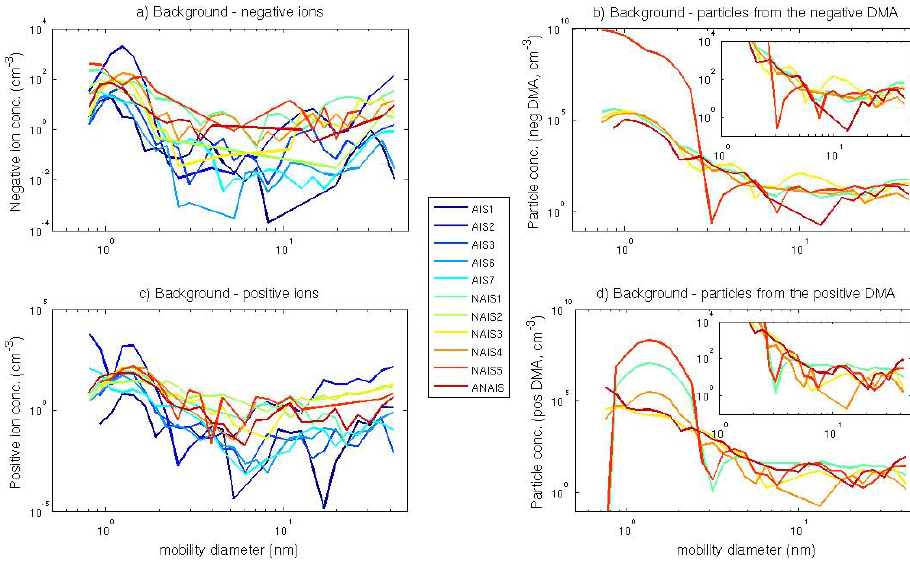
Fig. 5. The background concentrations is presented as a function of particle diameter. The total background concentration in ion measurement mode ( a and c ) was generally below 30cm − 3 for AISs and in the 30–150cm − 3 concentration range for NAISs. In particle measurement mode ( b and d ), the median total background concentration was 1.6 × 10 5 cm − 3 and the median total background concentration above 3.4nm was 86.5cm − 3 . In these background measurements we used the Hauke DMA as a filter (by applying a zero voltage) to provide the ion spectrometers with particle-free